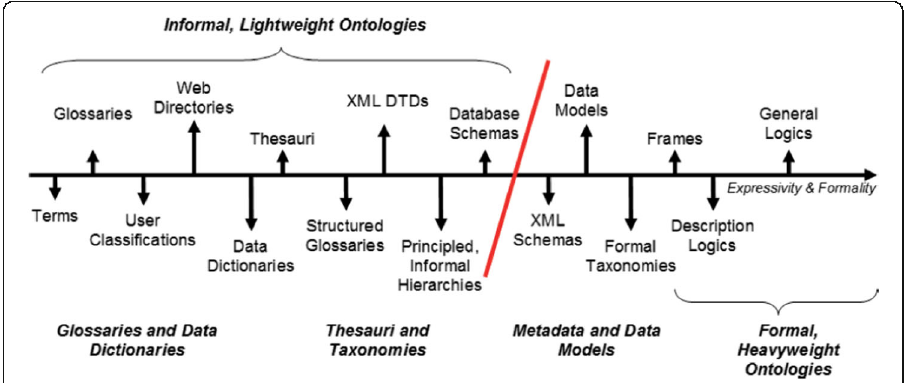
Fig. 1 A spectrum of ontologies from Wong, Liu, and Bennamoun